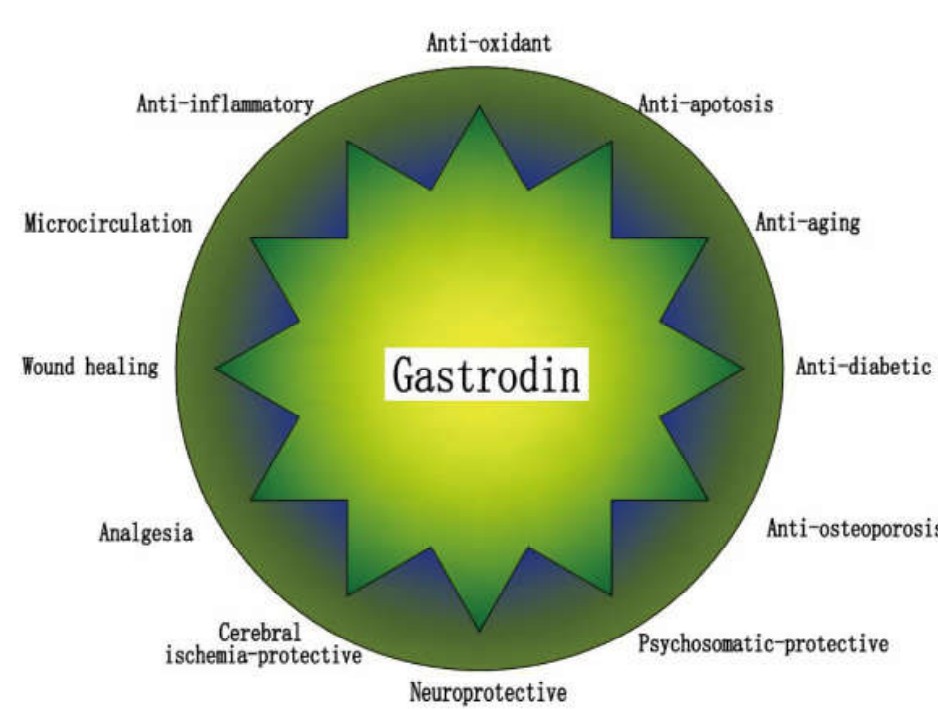
Figure 2. Summary of the beneficial effects of gastrodin.